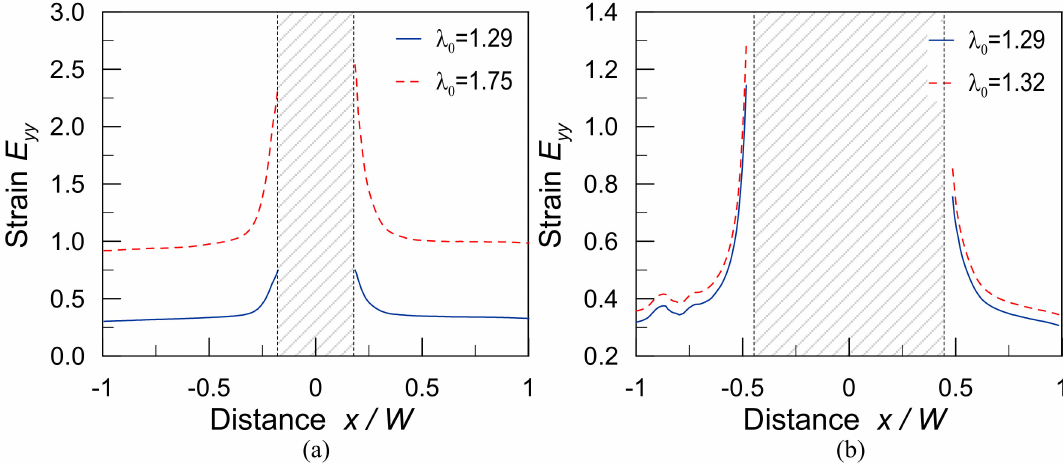
Figure 5. Images of the precracked specimens at the initial stage (left column), and with maps of the Green–Lagrange strain E yy at an intermediate stage (central column) and final stage at incipient failure (right column). The remote stretch is shown on the top of each plot. ( a – c ) Specimens type CC1 ( a/W = 0.179); ( d – f ) specimens type CC4 ( a/W = 0.446). In (b,e), the length scale is expressed in cm. The distribution of the Green–Lagrange strain E yy along the x -axis is shown in Figure 6.